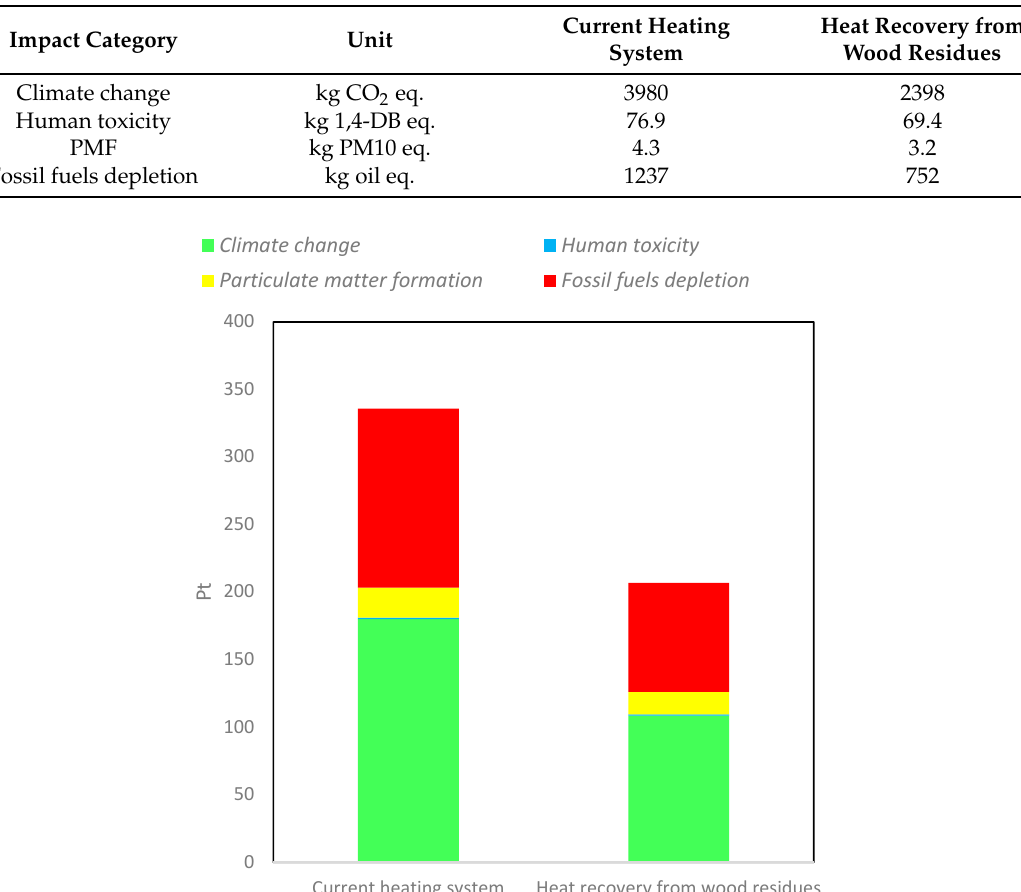
Table 4. Comparison between the current heating system and the wood-based scenario for the production of 1 MWh of thermal energy, at midpoint level. The expression eq. stands for equivalent; and PMF: particulate matter formation.